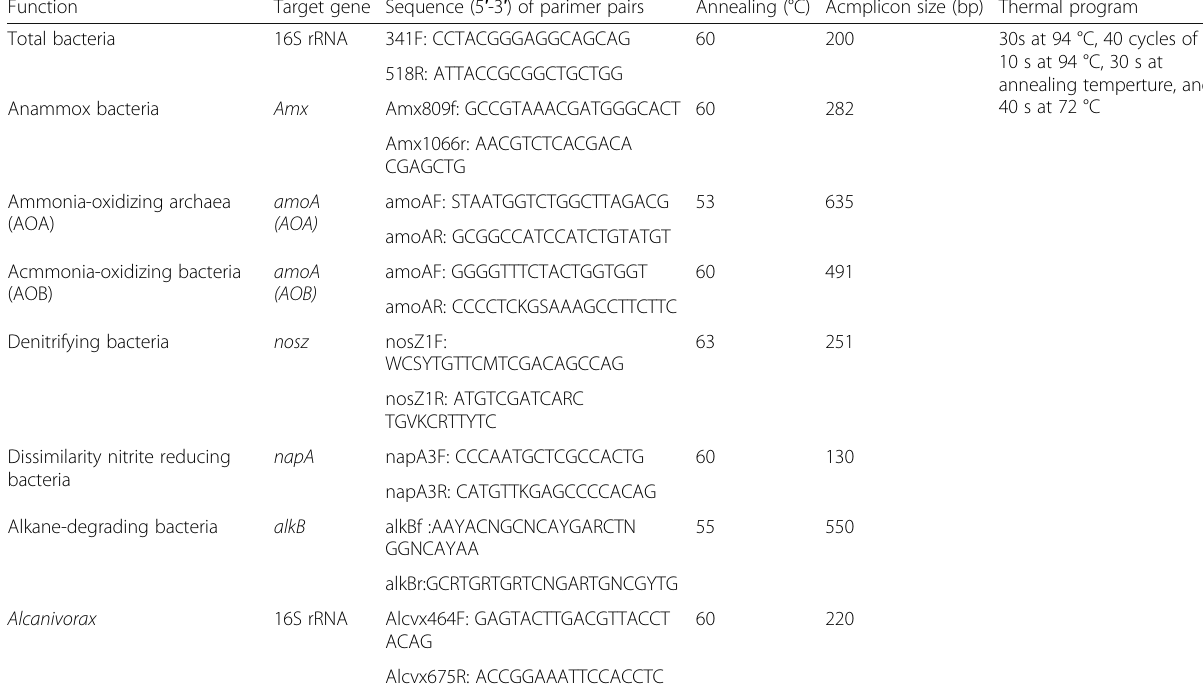
Table 1 Primers used for qPCR and thermal programs in this study